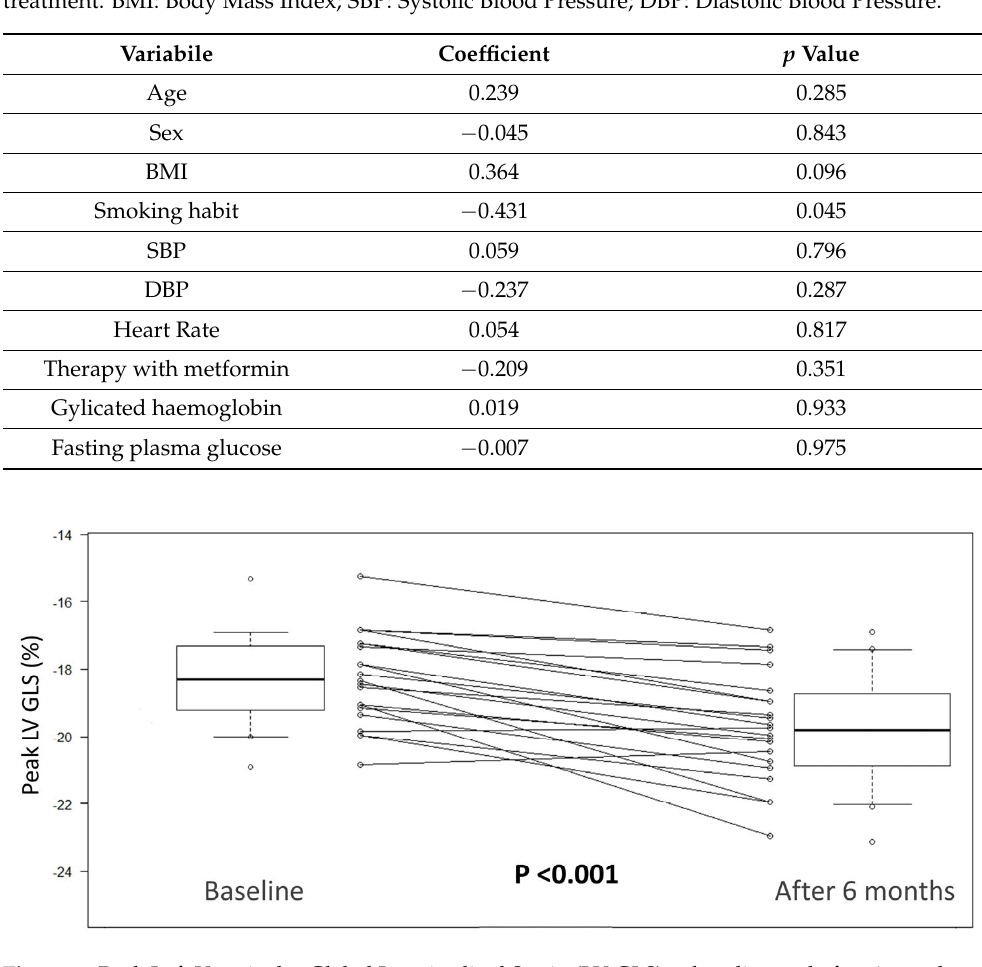
Figure 2. Peak Left Ventricular Global Longitudinal Strain (LV GLS) at baseline and after 6 months of treatment. The boxplots and the lines graph show a statistically significant ( p < 0.001) improvement of LV GLS after 6 months of treatment with GLP1 ‐ RAs. Table 1. Baseline characteristics of the study population. BSA: Body Surface Area; BMI: Body Mass Index; SBP: Systolic Blood Pressure; DBP: Diastolic Blood Pressure; CAD: Coronary Artery Disease; MI: Myocardial Infarction; COPD: Chronic Obstructive Pulmonary Disease; CKD: Chronic Kidney Disease; PAD: Peripheral Artery Disease; eGFR: estimated Glomerular Filtration Rate; ALT: Alanine ‐ amino Transferase.